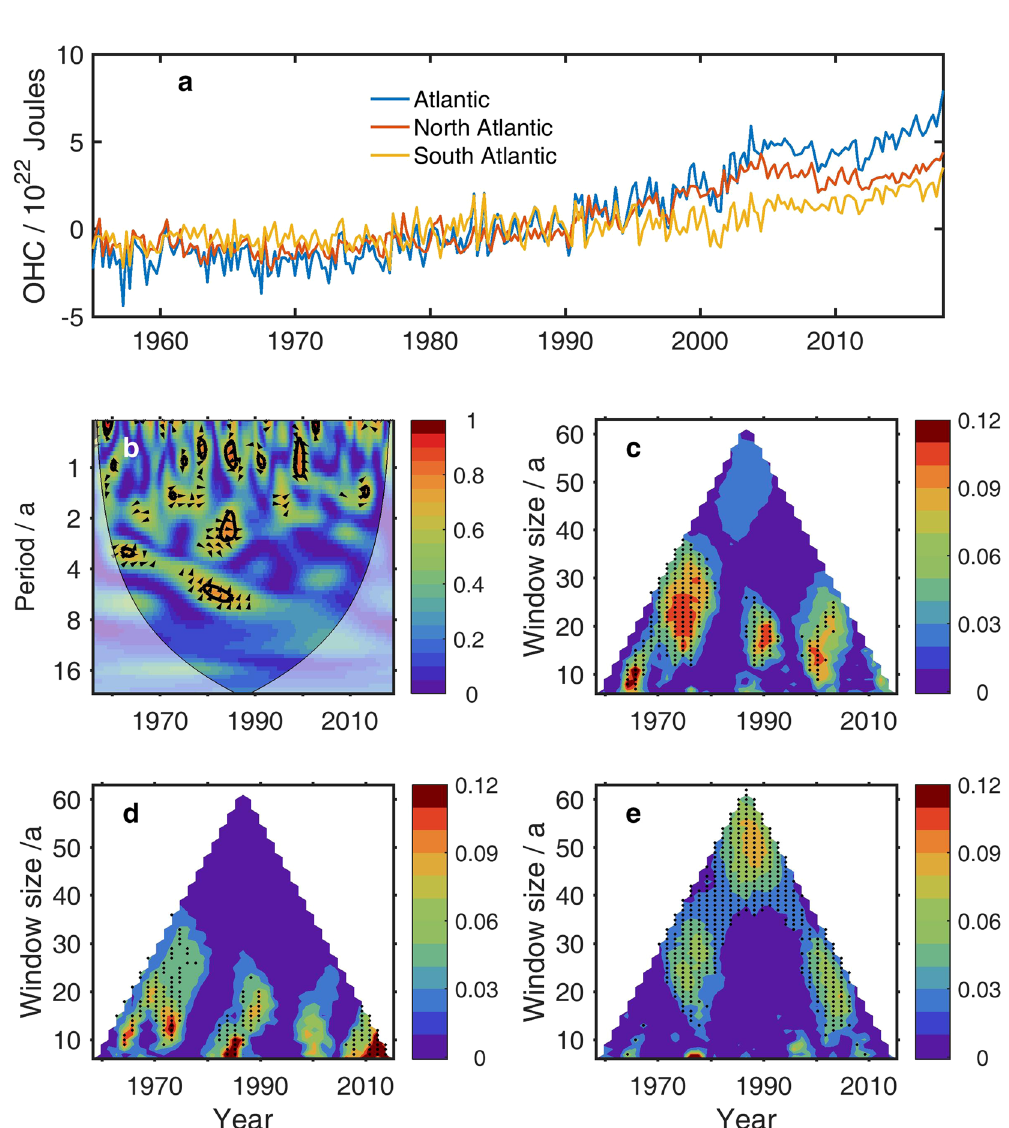
Figure 4. The original incorrect version of Figure